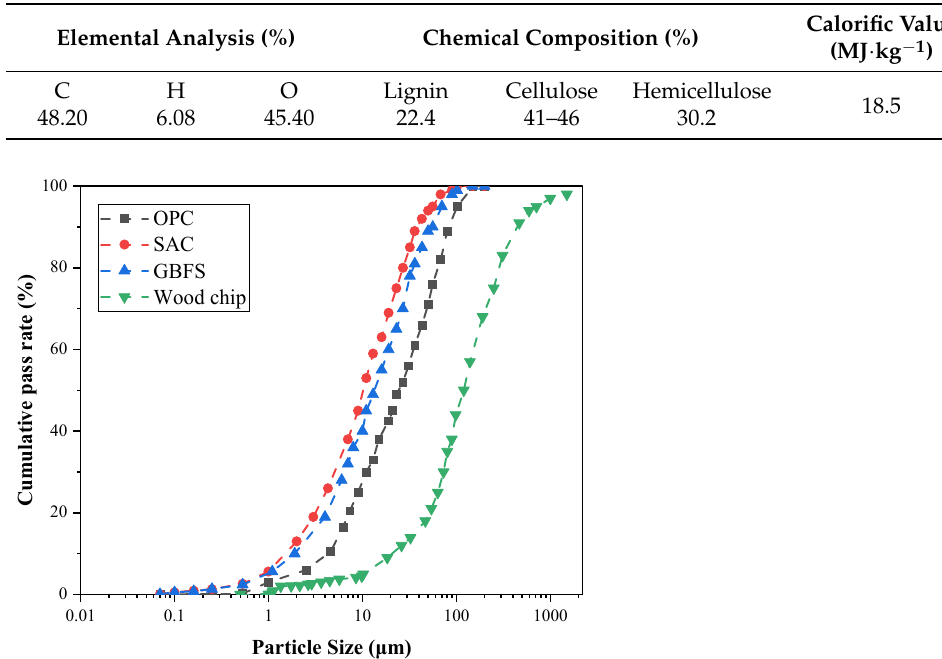
Table 2. Elemental analysis and chemical composition of the pine wood chips.